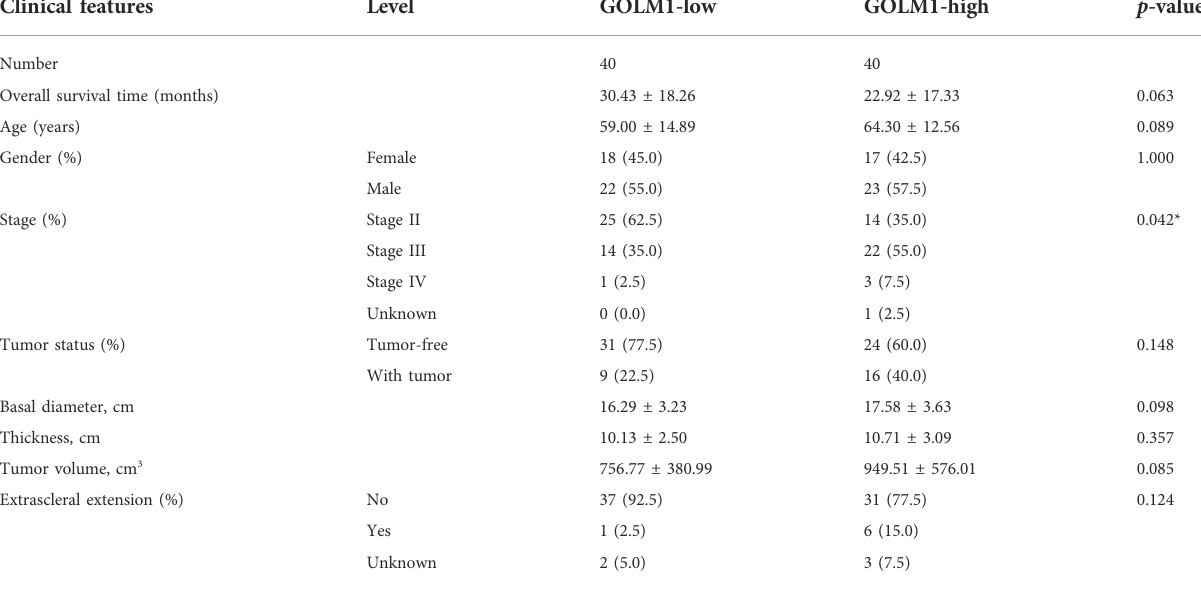
TABLE 2 Summarization of the clinical features in TCGA-uveal melanoma